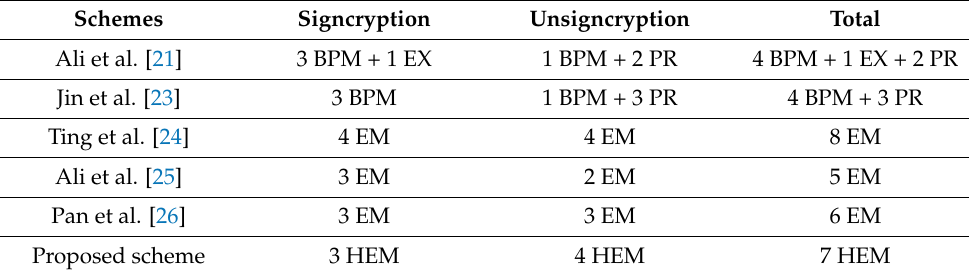
Table 3. Comparison of computation costs with major